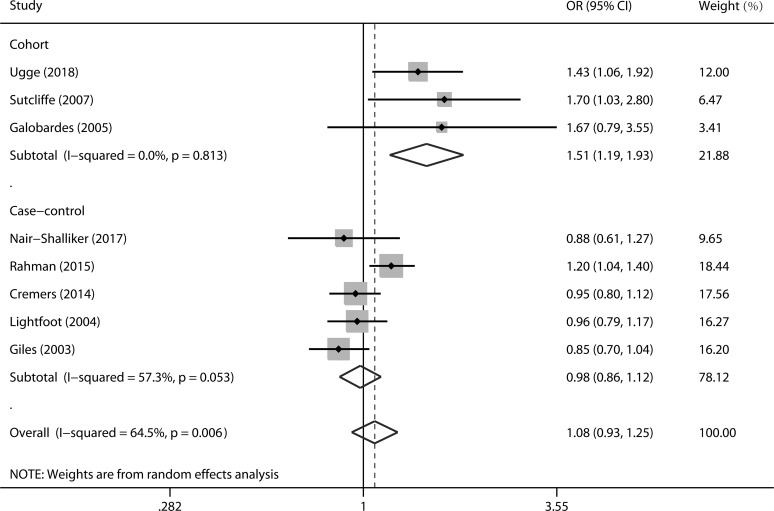
Forest plots showing risk estimates from cohort and case-control studies estimating the association between acne and the risk of prostate cancer.